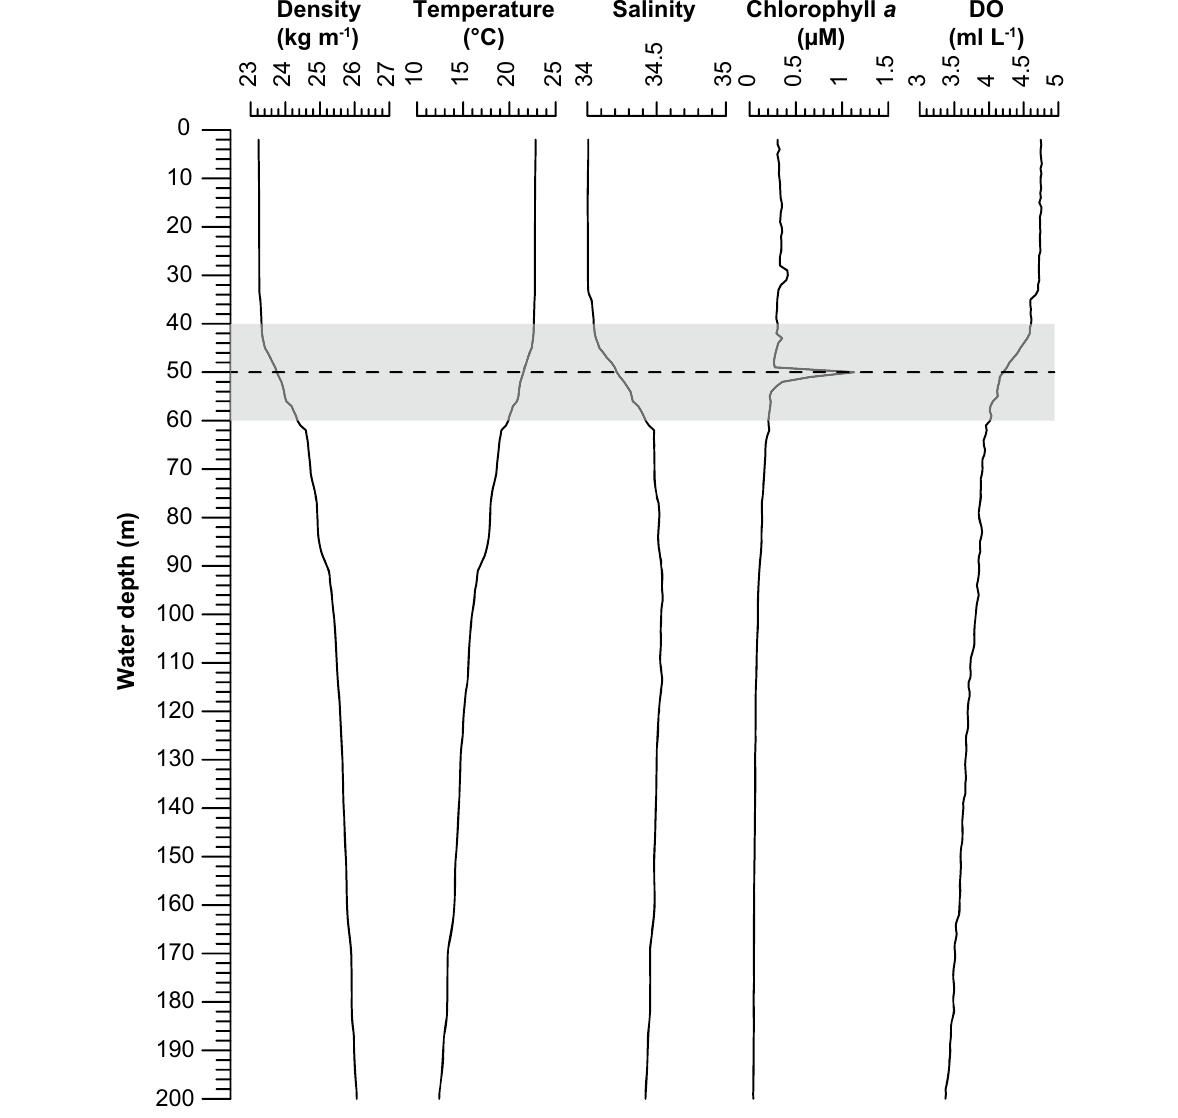
3.3 Zooplankton and particulate organic matters Zooplankton, excluding planktonic foraminifers, were abundant in the upper 50 m, gradually decreas- ing at deeper depth (Fig. 4, Additional file 2: Table S3). Copepods were the most common zooplankton, accounting for more than 80% of the total zooplank- ton standing stock. Of the copepod assemblage, Cala- noida, Cyclopoida, and Poecilostomatoida were more common than other taxa, comprising more than 95% of the assemblage. Decreasing zooplankton abundance